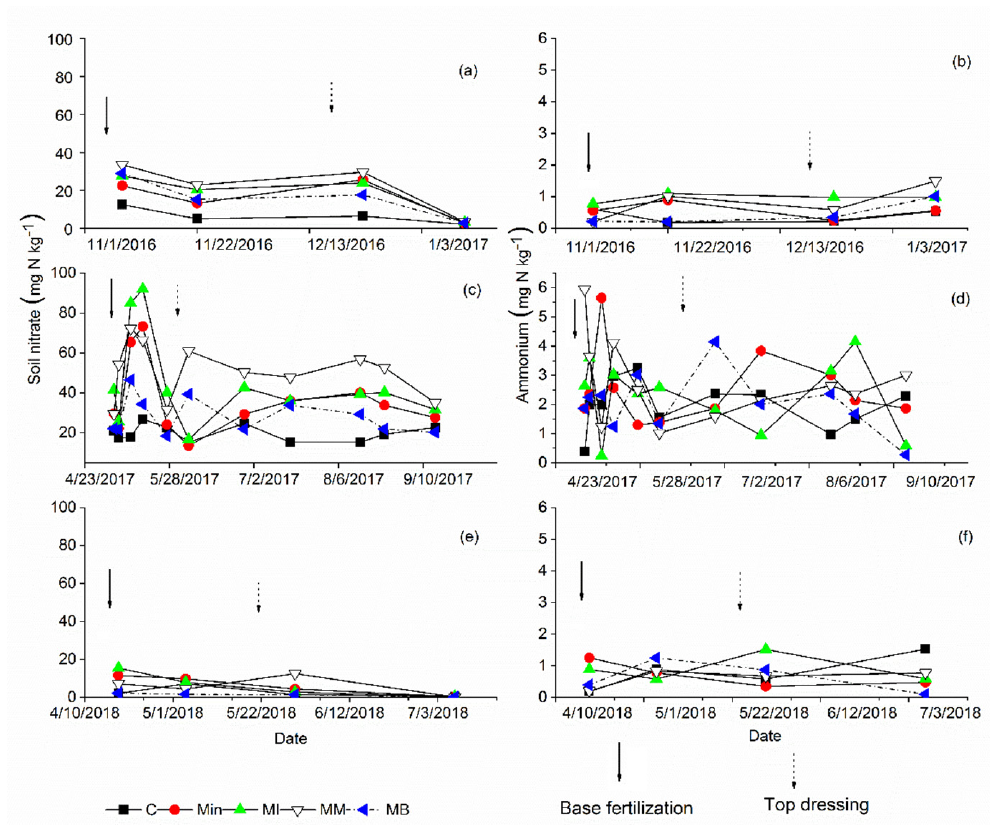
Figure 4. Soil nitrate (mg kg − 1 soil), ( a − c ) for seasons 1, 2, and 3, respectively, and soil ammonium (mg kg − 1 soil) ( d − f ) for seasons 1, 2, and 3, respectively, measured during gas sampling to a depth of